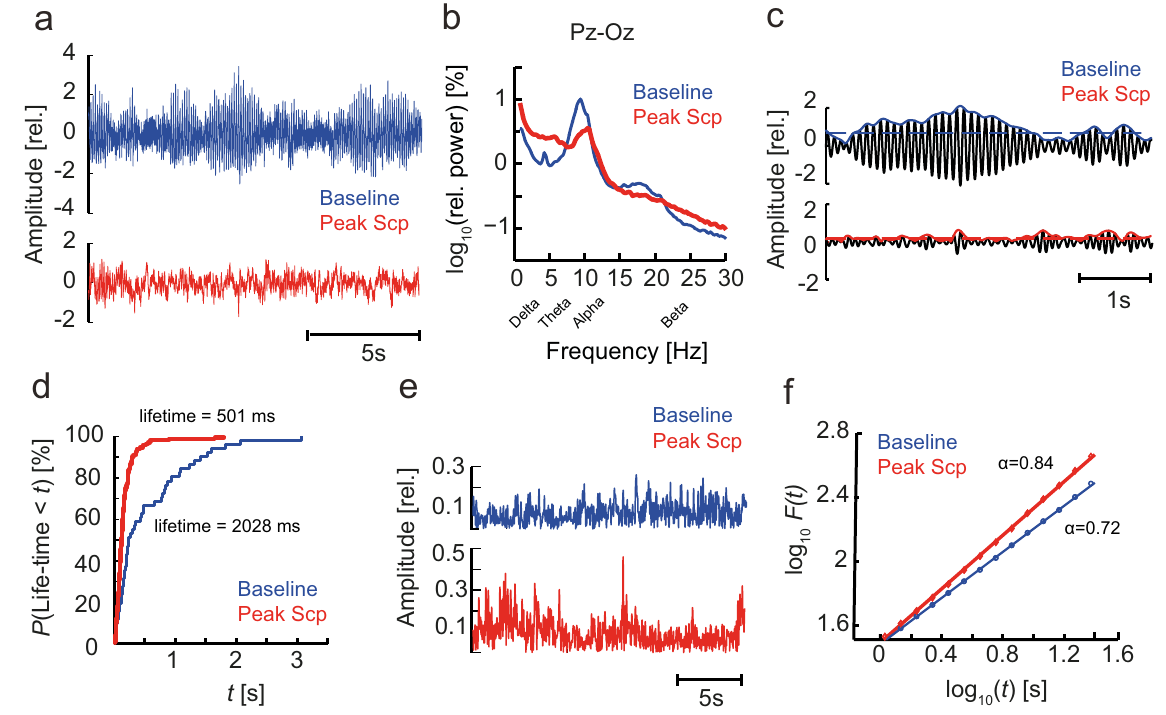
Figure 1. Spectral and temporal correlation biomarkers exhibit sensitivity to scopolamine administration. ( a ) EEG of a subject in the baseline ( blue ) and scopolamine ( red ) condition. ( b ) Grand average normalized power spectra indicate large effects of scopolamine, most notably a reduction of power in the alpha and beta bands, and an increase of delta and theta power. ( c ) Oscillation dynamics were studied by extracting the amplitude envelope from band-pass filtered data (e.g., the alpha band, black ) using the Hilbert transform ( blue , red ) and a median-amplitude threshold to determine the onset and offset of a burst. ( d ) A cumulative probability distribution of all oscillation bursts revealed a tendency towards longer alpha bursts in the baseline condition. ( e ) Amplitude envelopes of beta oscillations (13–30 Hz) suggest a more complex temporal structure in the peak scopolamine ( red ) than in the baseline ( blue ) condition on time scales of seconds to tens of seconds. ( f ) The long-time scale differences in beta oscillations are reflected in the grand average DFA showing larger scaling exponents for peak scopolamine ( red ) than for the baseline recording ( blue ). All figures were based on the Pz-Oz